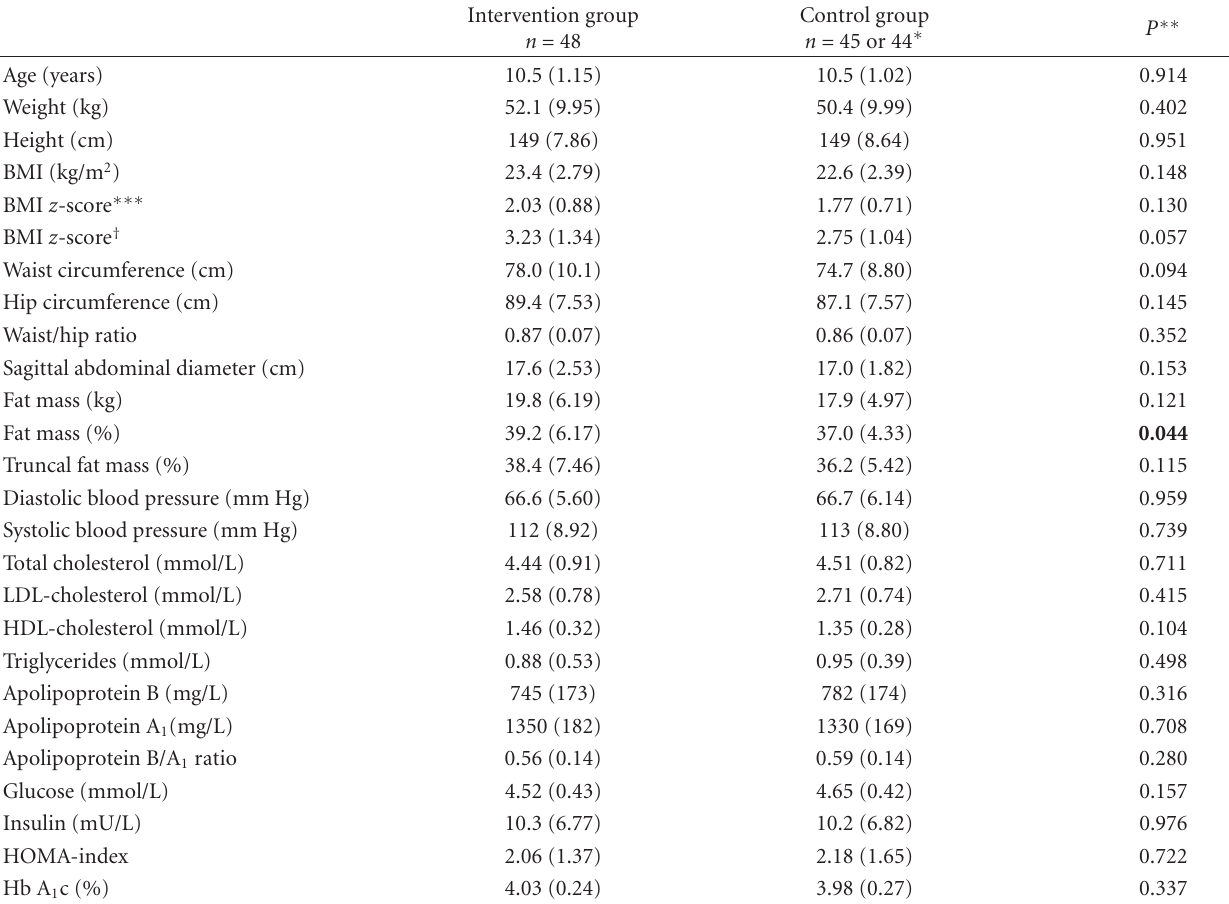
Table 1: Baseline characteristics; anthropometric measures, and fasting blood values, of overweight and obese children presented as mean (standard deviation).